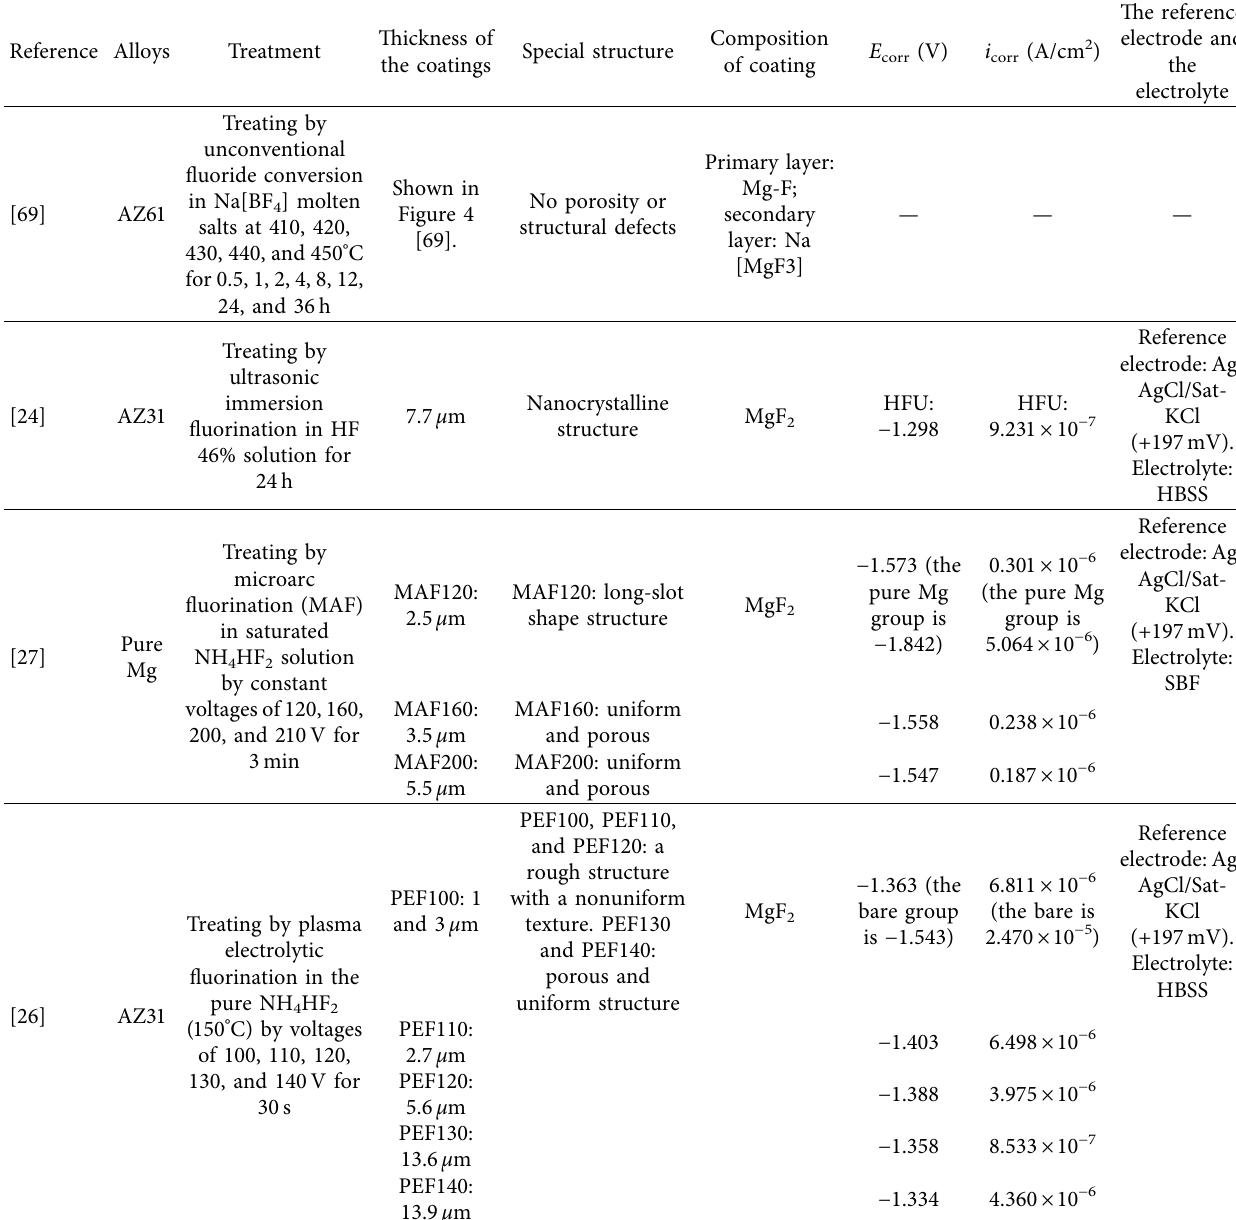
Table 2: Characteristics of different HF-coated magnesium alloys prepared under various parameters. Reference Alloys